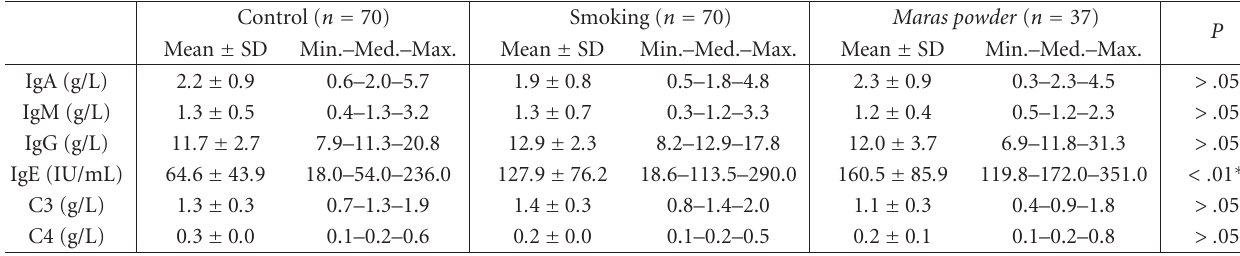
Table 1: Comparison of humoral immune system parameters in study groups.